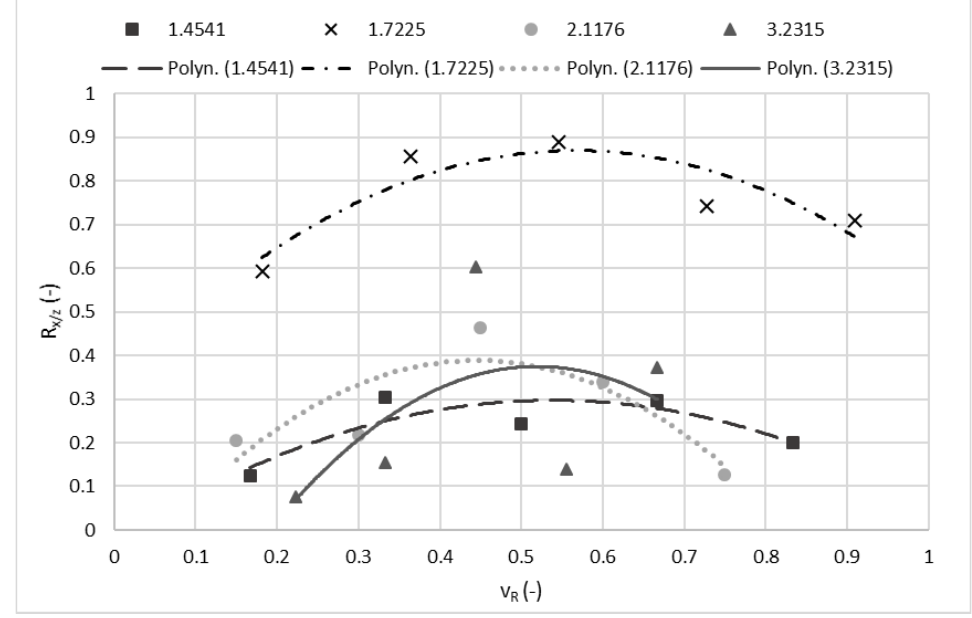
Figure 4. Ratio (R x/z ) of the x -axis forces to the z -axis forces in relation to the relative traverse speed.